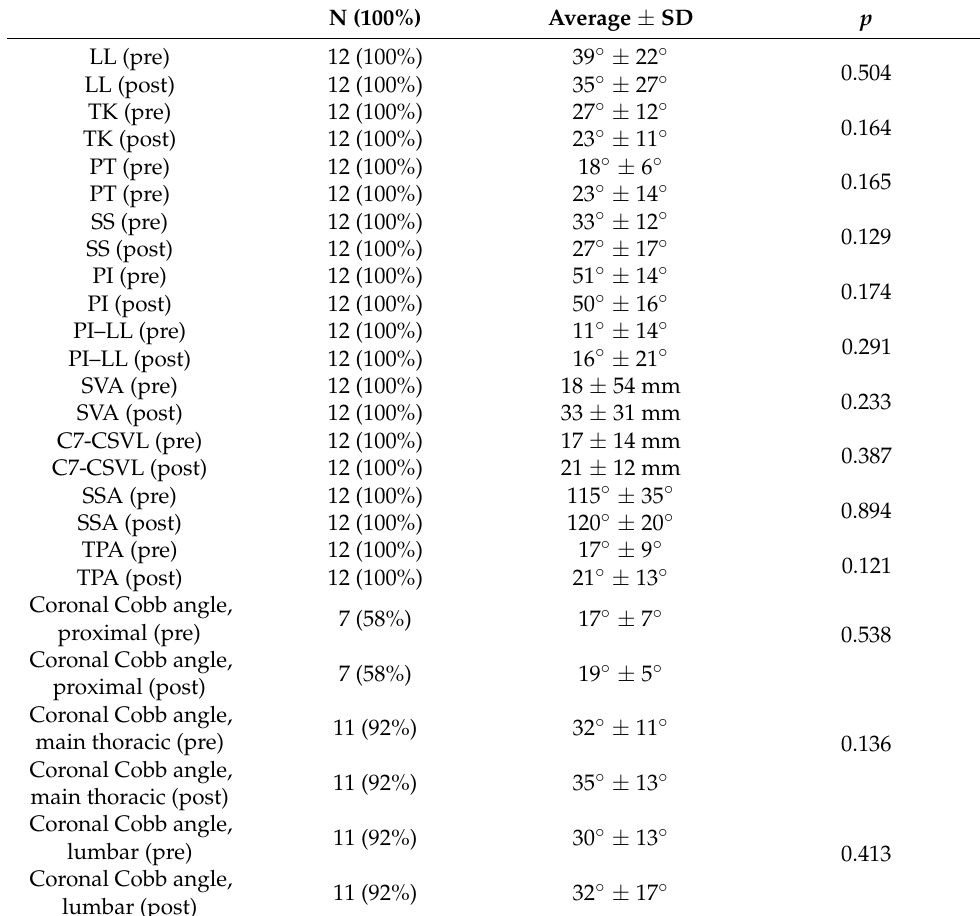
Table 2. Comparison of pre- and most recently post-HR instrumentation removal radio- graphic